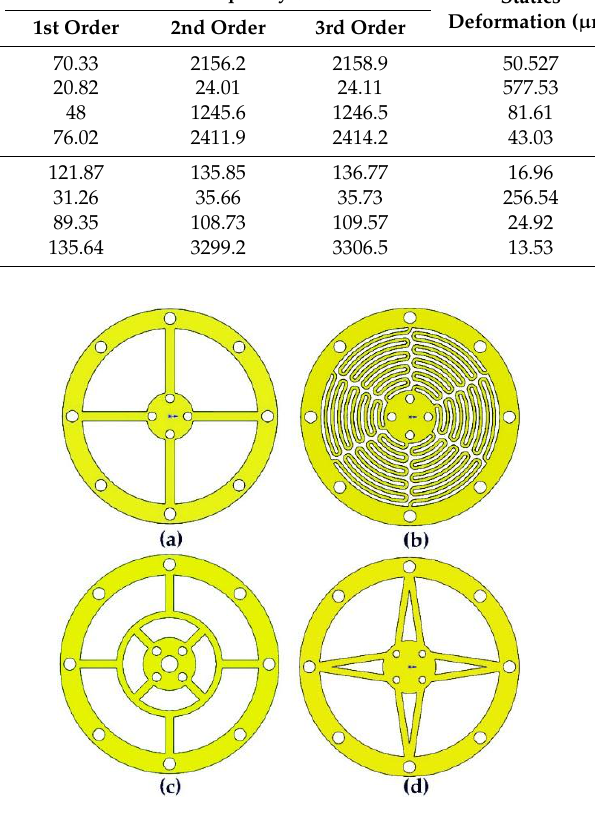
Table 2. Modal analysis and static analysis.